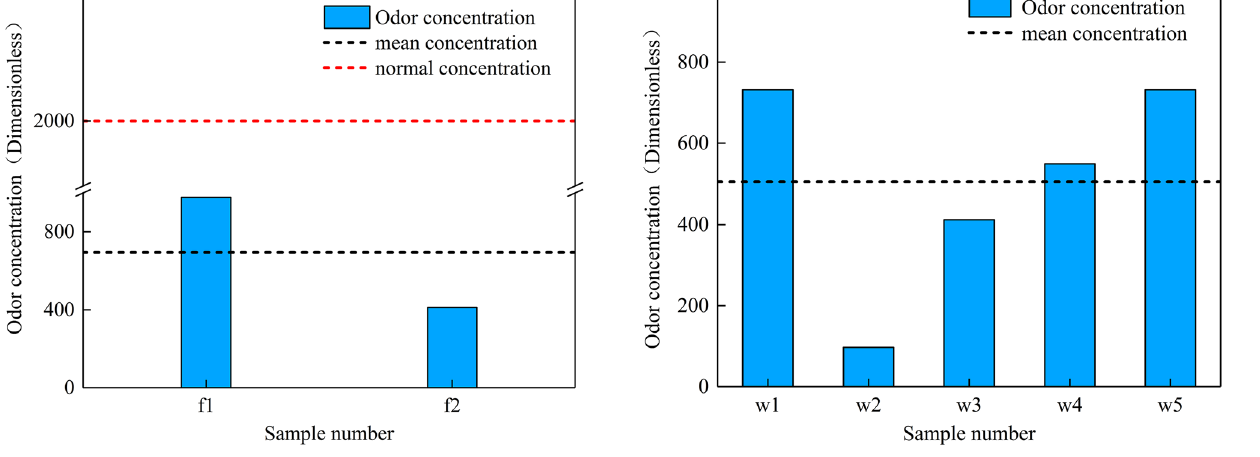
Fig. 4 The level of odor emissions of incinerators Fig. 5 The odor level in cremation